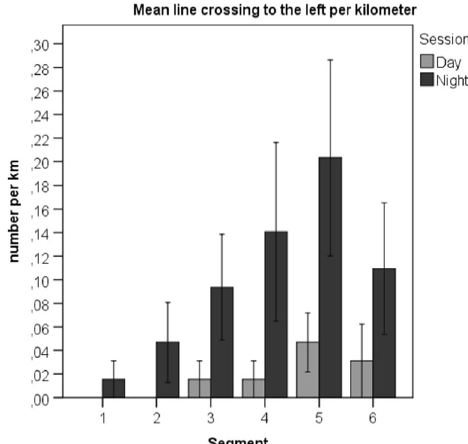
Fig. 4 Line crossings left, day and night for road segment 1 – 6 along the road. Error bars represent Standard error of mean